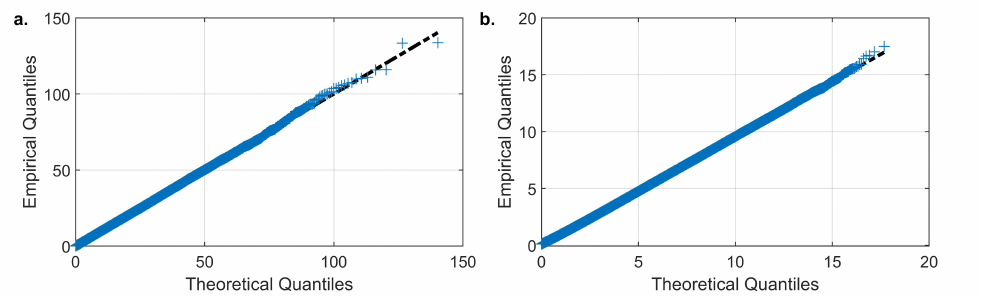
Figure 6. Comparison between empirical and theoretical quantiles for Precipitation { X t } ( a ) and Evaporation { Y t } ( b